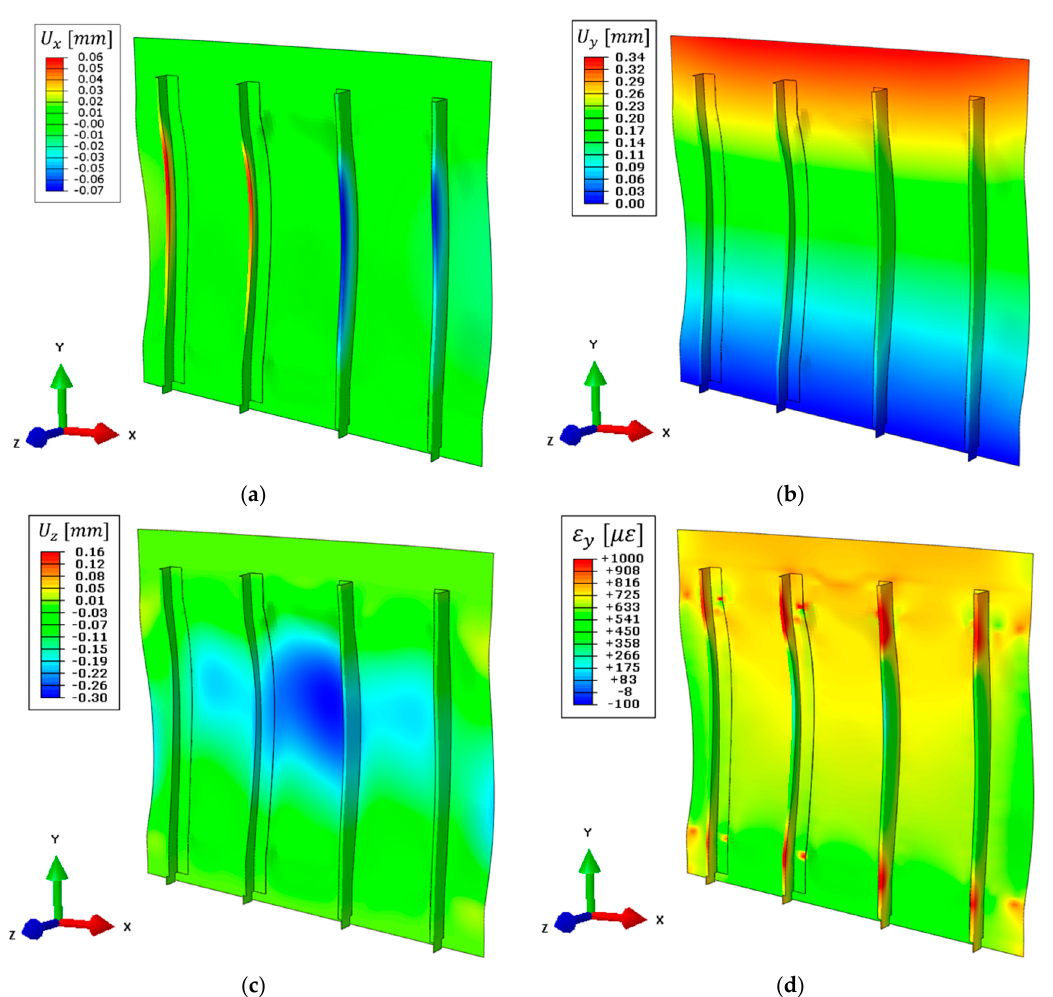
Figure 13. Simplified iFEM model results with experimental sensor network and numerically simulated input strain field affected by noise, deformed shape with scale factor 100: ( a ) Displacement field on the x-direction, ( b ) displacement field on the y-direction, ( c ) displacement field on the z-direction, ( d ) strain field on the y-direction on the top side of the structure.